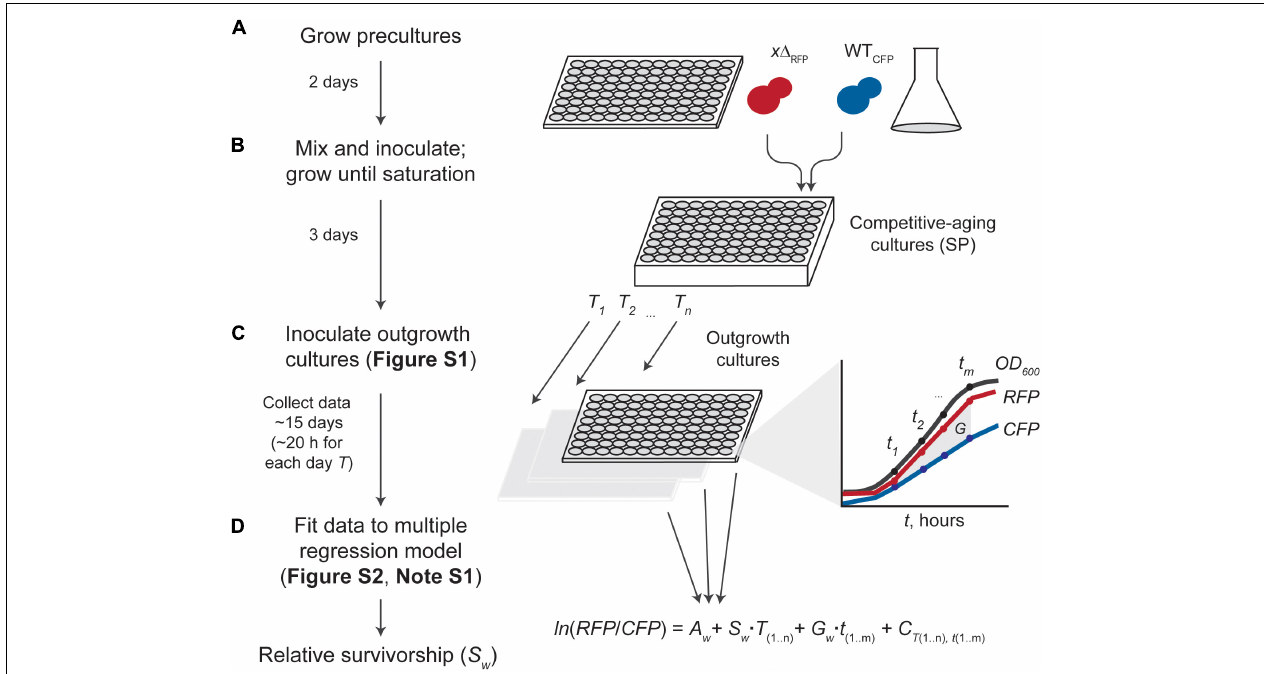
FIGURE 1 | Experimental and data-analysis workflow. (A) Starting cultures of fluorescence-tagged gene deletion ( x (cid:49) RFP ) and wild-type reference (WT CFP ) are grown separately. (B) Saturated cultures are mixed (usually in a 1:2 WT/ x (cid:49) ratio for increased dynamic range) and inoculated into SC aging medium in a semi-deep well plate until stationary phase (SP). (C) Competitive-aging cultures are sampled regularly at days t ; outgrowth cultures in fresh medium are monitored at T hours with simultaneous measurement of absorbance at 600 nm ( OD 600 ), and raw RFP and CFP signals ( Supplementary Figure S1 ). Possible differences in growth rate ( G ) are taken into account. (D) Data analysis uses the change in fluorescent-signal ratio in the outgrowth cultures to estimate the relative survivorship of each mutant ( S w ). Data is fitted to a multiple linear-regression model considering the change of ln(RFP/CFP) empirical measurements over time as a function of the starting strains’ proportion ( A ), the mutant’s relative growth rate ( G ), systematic batch errors in the measurements ( C ), and the mutant’s survivorship relative to the wild-type ( G ), our parameter of interest ( Supplementary Figure S2 and Note S1